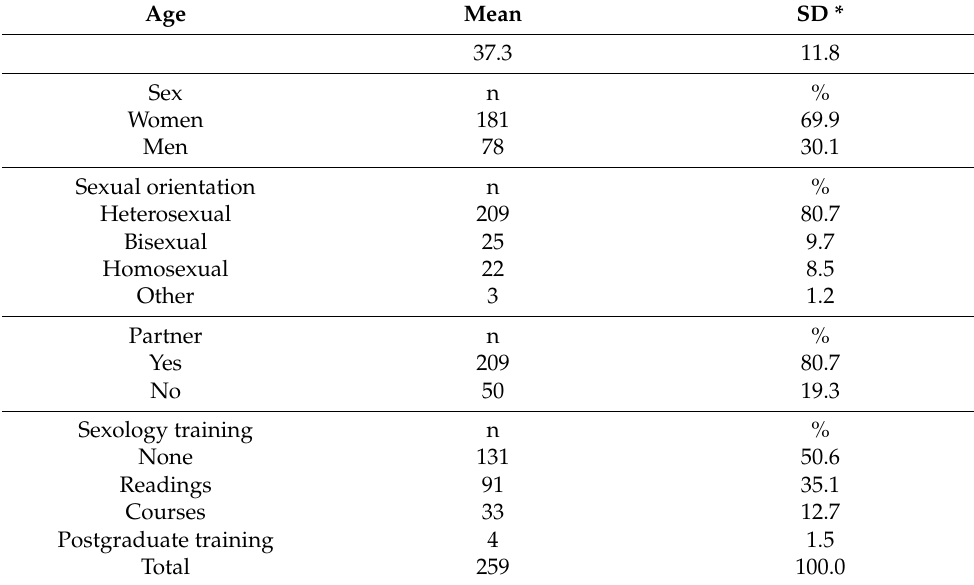
Table 1. Sociodemographic